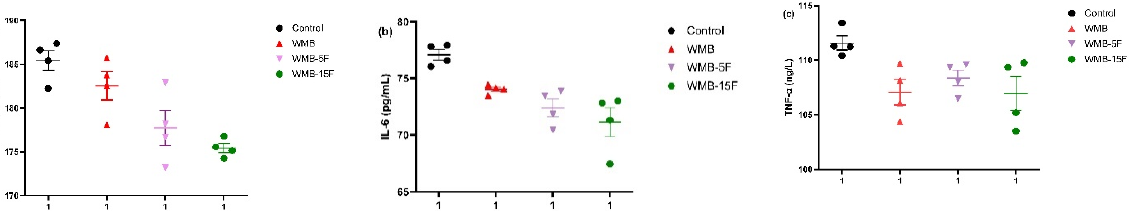
Figure 3. Effect of pitaya fermentate in bread diets on pro-inflammatory cytokines, including IL-1 β ( a ), IL-6 ( b ), and TNF- α ( c ). Bars represented the mean ± SEM ( n = 4).